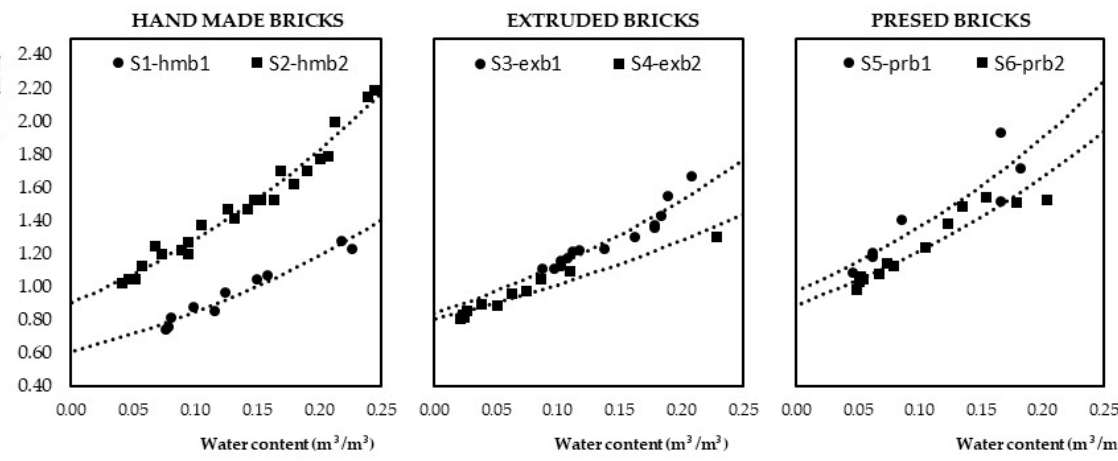
Figure 5. Results of heat flow and water content tests of brick masonry samples. Table 5. Dry and saturated conductivity of the samples, test results, and ratio between the apparent and real porosity of the bricks used to make the